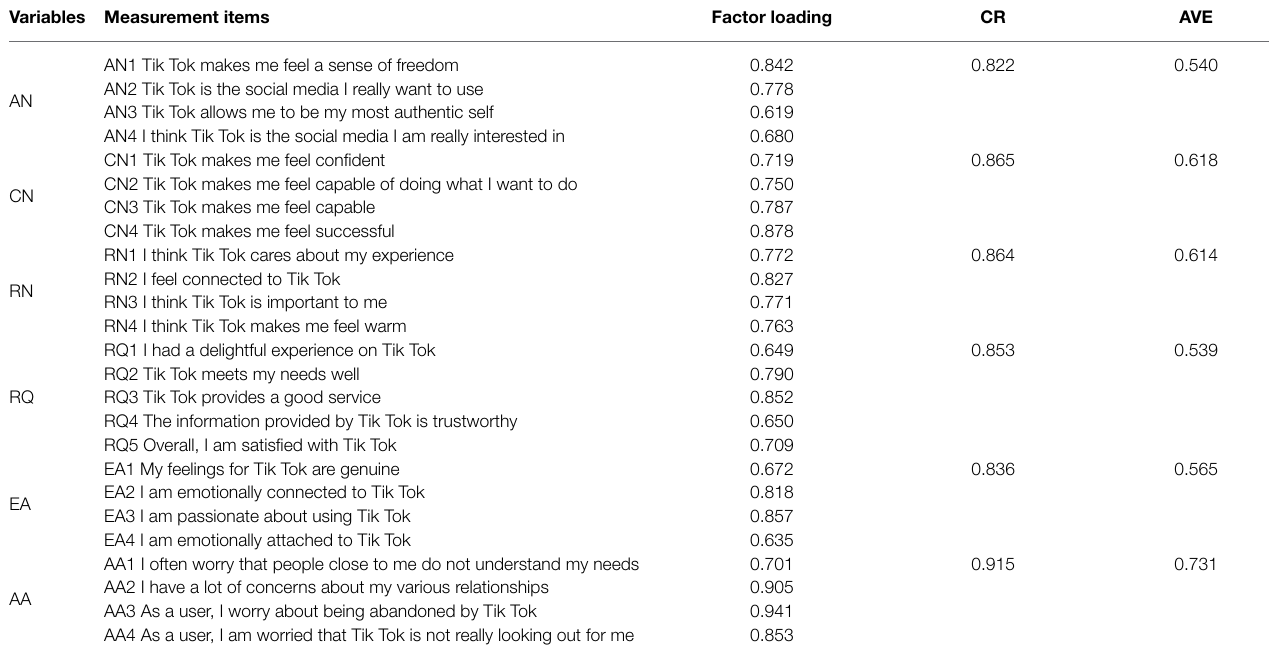
TABLE 2 | The analysis of confirmatory factor analysis (CFA).